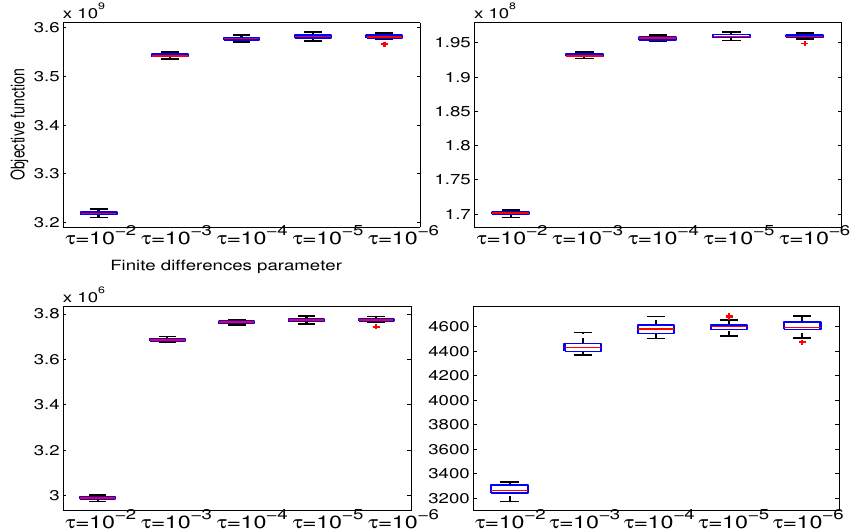
Figure 3. Box plots of objective function values for the Lorenz 63 problem. From the left to the right and from the top to the bottom, the figures correspond to the results of the first, second, third and fourth iterations, respectively. The whole state is observed. Ensemble size is 50. The assimilation window is 50 cycles. In each box, the central line presents the median (red line), the edges are the 25th and 75th percentiles (blue line), the whiskers extend to the most extreme data points the plot algorithm considers not to be outliers (black line), and the outliers are plotted individually (red dots).